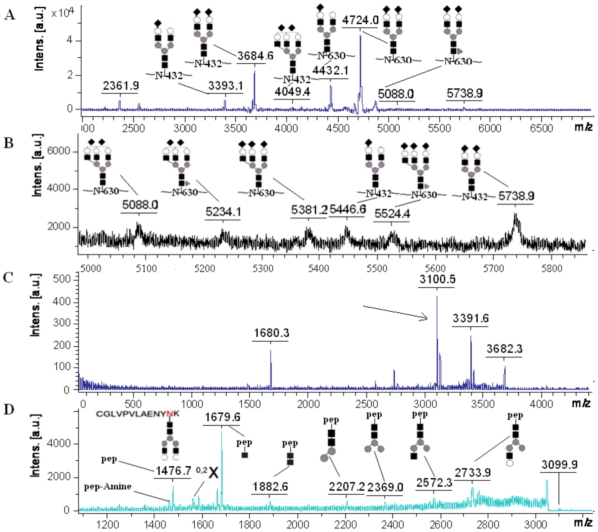
MS and MS/MS spectra of glycopeptides from 10 pmol gel-separated human transferrin.(A) Mass spectrum of the glycopeptides of human transferrin. (B) The enlarged view of Figure 2A, which shows low-abundance glycopeptides more clearly. (C) Mass spectrum of the parent ion of m/z 3684.6 obtained in TOF/TOF mode. The difference between 3682.3, 3391.6 and 3100.5 is about 291. (D) MS/MS spectrum from the precursor indicated by arrow in Figure 2C. The mass of [Mpep+H]+ was 1476.7. Glycan structures were deduced based on the difference between adjacent signals and its biosynthesis process.